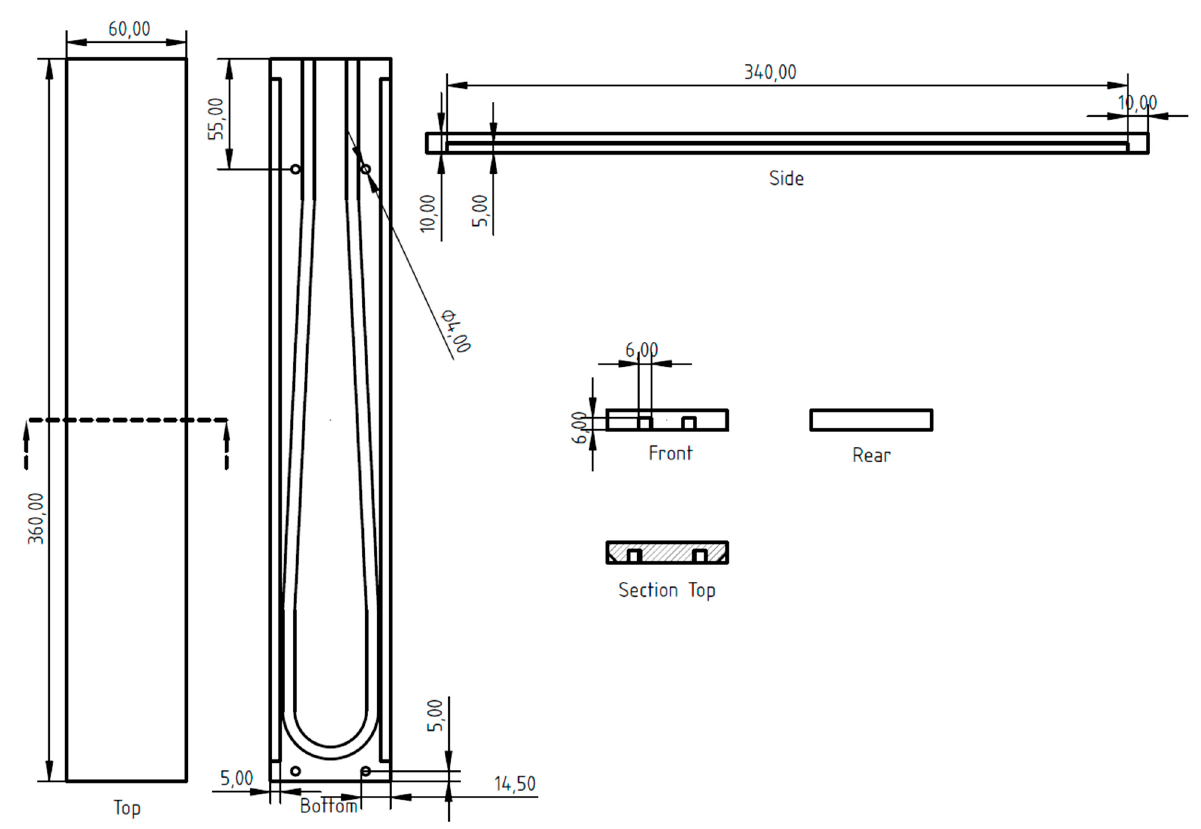
Figure A3. Technical drawing of the heat exchanger. Dimensions in mm. A comma is used as decimal separator in this figure.